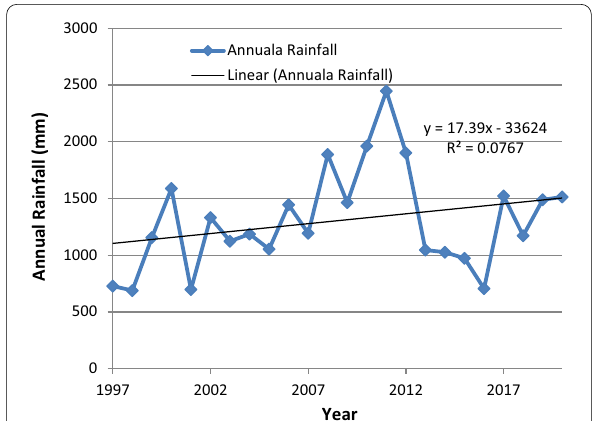
Fig. 4 Trend of annual rainfall (mm) distribution from 1997 to